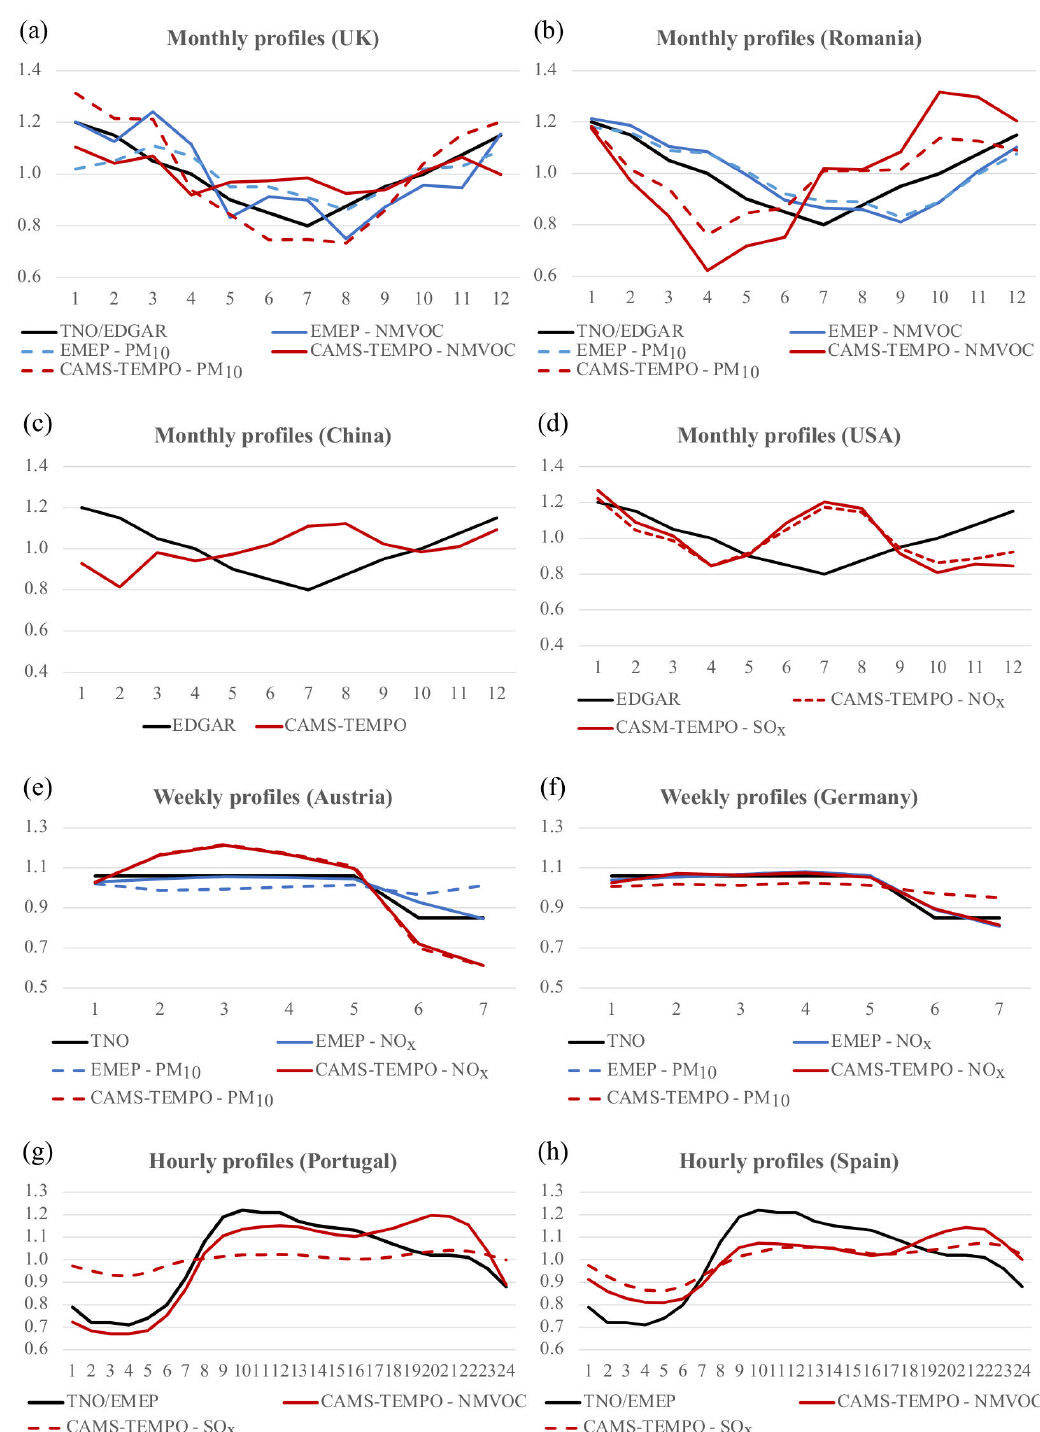
Figure 12. Comparison of monthly (a, b) , weekly (c, d) and hourly (e, f) profiles for energy industry emissions developed in the present work (CAMS-TEMPO) with profiles from EDGAR, EMEP and TNO for selected